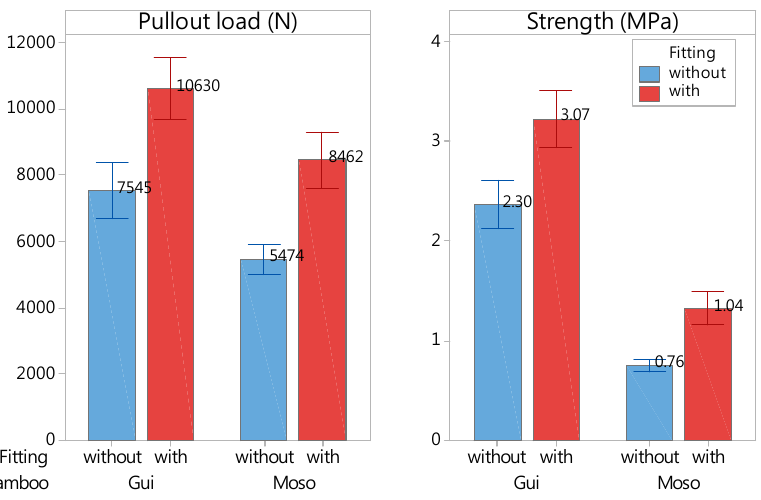
Figure 12. The pullout loads and strengths of various joints (bars are one standard error from the mean).